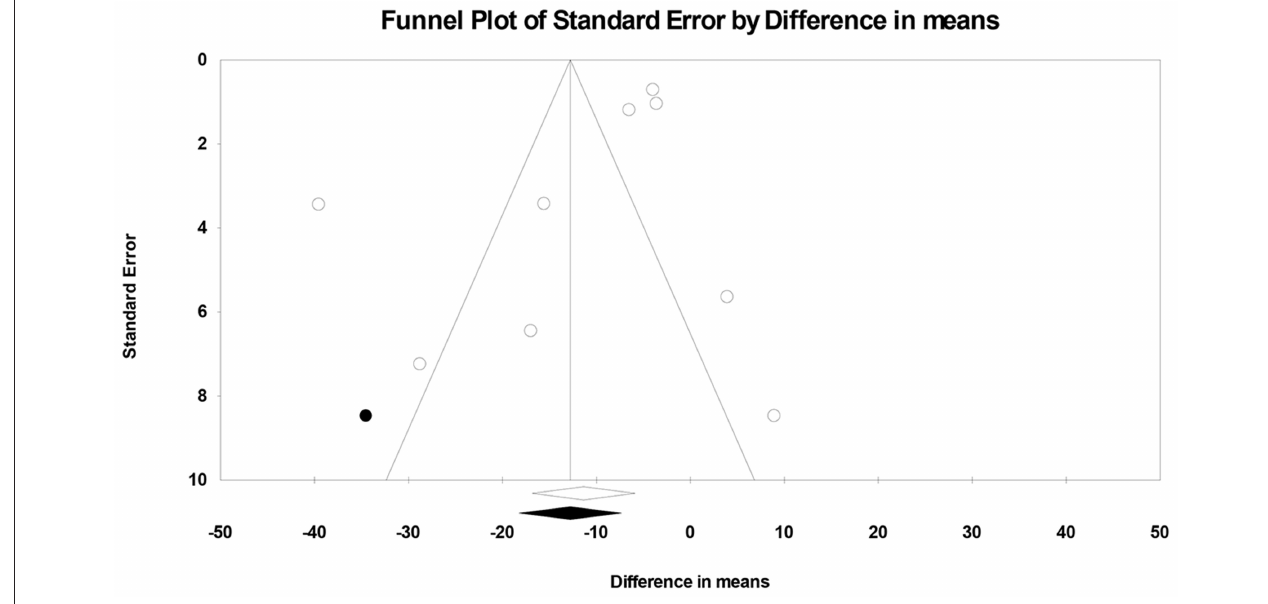
FIGURE 3 | Corrected funnel plot showing publication bias in animal studies that compared the effect of coenzyme Q 10 with vehicle treatment or no treatment on myocardial infarct size in models of myocardial ischemia-reperfusion